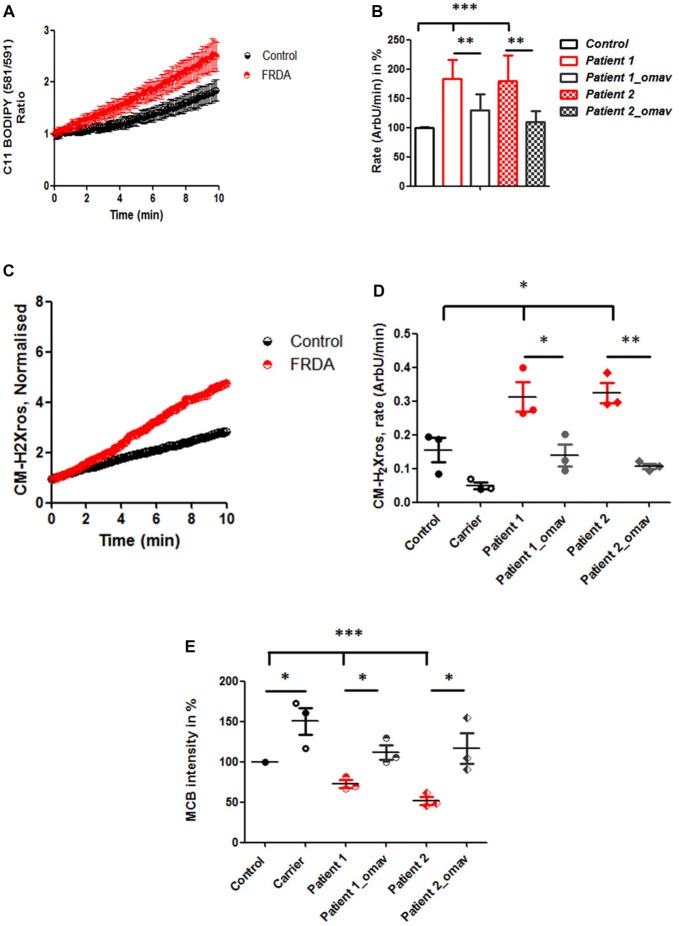
Oxidative stress in FRDA fibroblasts is prevented by omav. (A) Lipid peroxidation was measured in Control and FRDA cells with C11 BODIPY (581/591) using live imaging over time. (B) The ratio of the fluorophore was calculated (488/562 nm) and analyzed the rate of increase in percentage (%; taken Control as 100%). Patient 1 and 2 fibroblasts untreated showed a significant increase compared to Control (***p < 0.0005) and a significant decrease in rate after omav compared to untreated cells (**p < 0.005). (C) The curve shows the kinetic curve of CM-H2Xros generated by Control and FRDA cells. (D) The rate of increase was expressed in ArbU/min. The rates in untreated patients’ cells were significantly increased compared to Control (*p < 0.05) and patients’ cells untreated and treated with omav showed a significant difference (Patient 1 *p < 0.05; Patient 2 **p < 0.005). (E) Glutathione (GSH) was measured with monochlorobimane (MCB) and was lower in patients untreated compared to Control (***p < 0.0005) and the amount seemed to be restored in patients’ cells treated with omav (*p < 0.05).